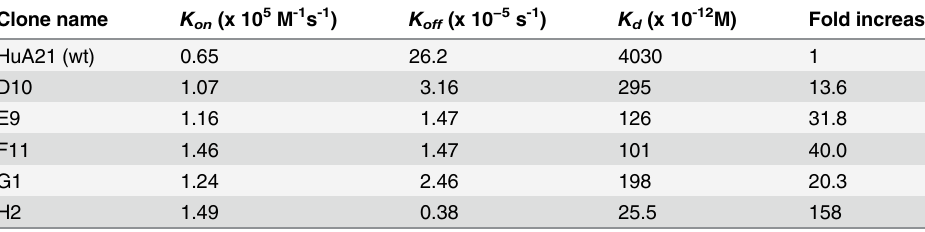
Table 3. Binding kinetics of the combinatorial library